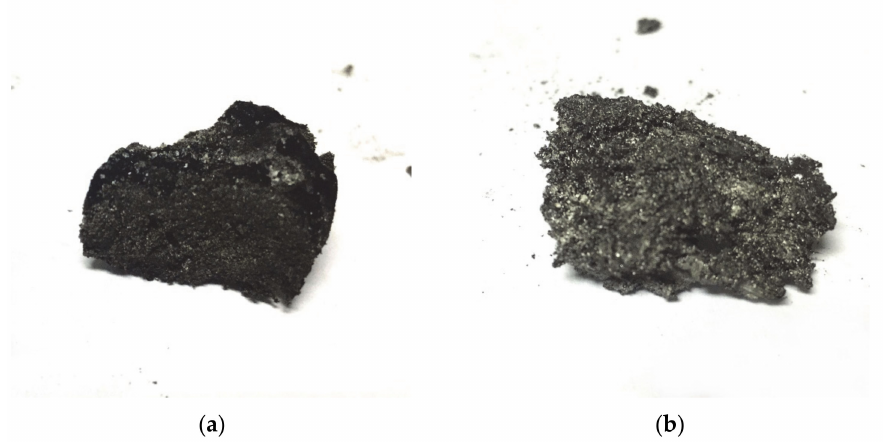
Figure 14. Char after experiment: ( a ) upper char layer; ( b ) lower char layer.